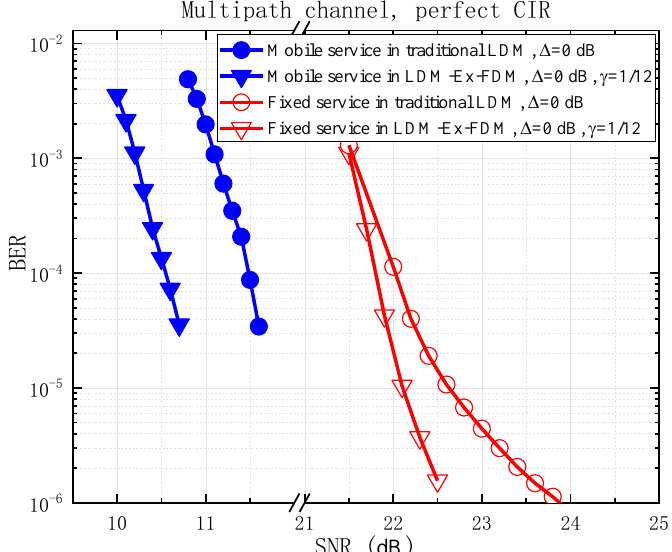
Figure 18. BER performance of mobile service and fixed service in ATSC 3.0 system with and without LDM-Ex-FDM scheme with perfect channel impulse response (CIR) under the multipath channel, where the parameters of the ATSC 3.0 system was set to ∆ = 0 dB, the CL constellation was set to QPSK, the EL constellation was set to NU − 64QAM, and the puncturing rate of the LDM-Ex-FDM scheme was set to